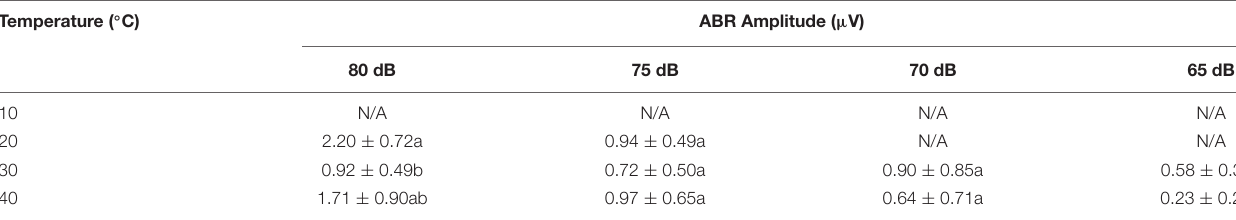
TABLE 5 | Differences in the auditory brainstem response (ABR) amplitude in Trachemys scripta elegans at each stimulus intensity among the temperature groups. Temperature ( ◦